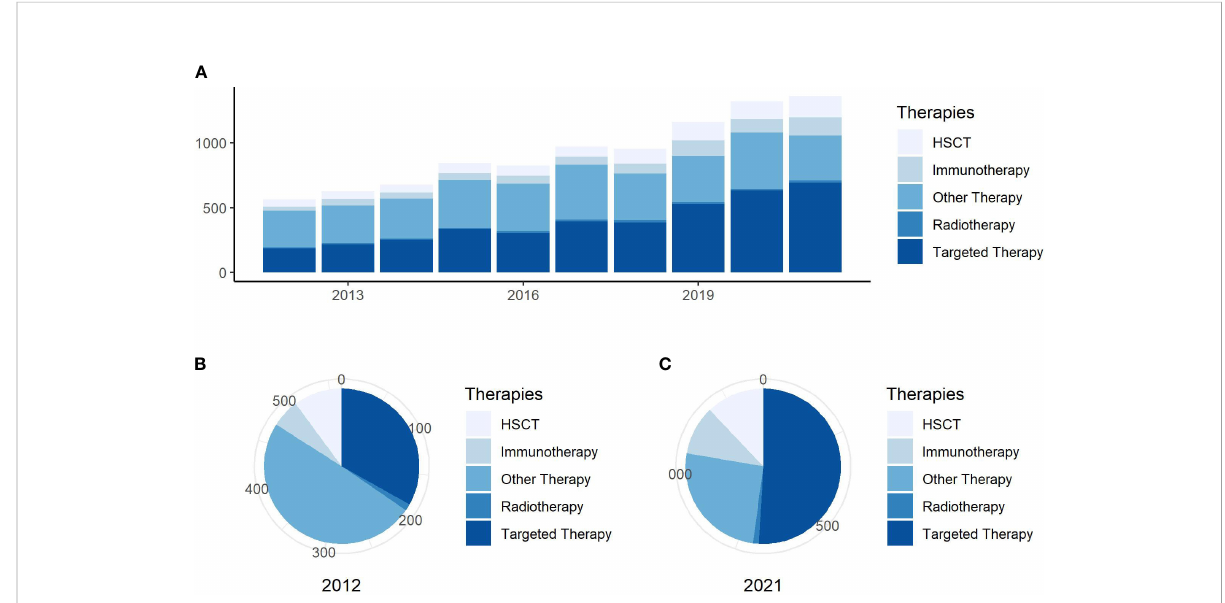
FIGURE 1 Annual publishing and proportion trends. (A) Trends in the number of publications per year on general research on AML treatment. (B) Proportion of publications about research for different AML treatment in 2012. (C) Proportion of publications about research into different AML treatment in